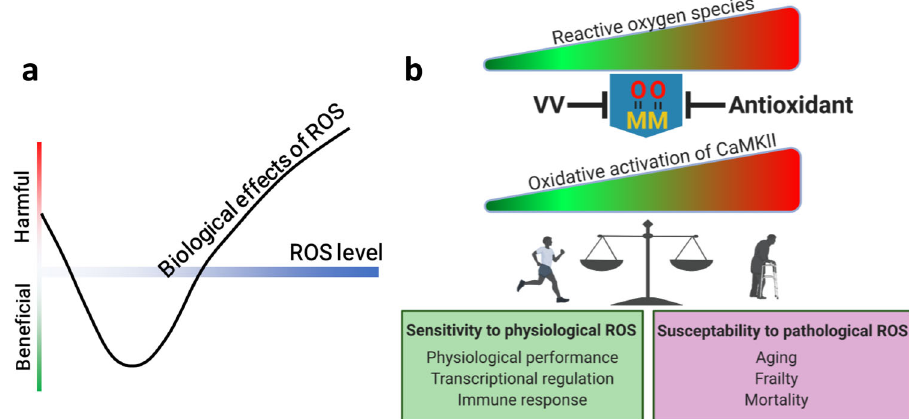
Fig. 7 The double-edged roles of CaMKII oxidation. a ROS induces a hormesis dose response, where too little or too much ROS are harmful, and optimal biological effects are achieved with an intermediate level of ROS. b ROS dictates the activity of CaMKII by oxidizing the MM/CM module. A physiological level of ROS allows CaMKII activity required for optimizing physiological functions, which is the likely reason for the evolution of the MM/CM module. Excessive oxidative stress induced by disease and aging hyperactivates CaMKII, which in turn aggravates frailty, diseases, and aging. Blocking oxidative activation of CaMKII by mutating MM residues to VV or by antioxidants protects against pathological processes accompanied by excessive oxidative stress, but also negates the physiological bene fi ts of CaMKII oxidation. Diagrams were created with BioRender.com. NATURE COMMUNICATIONS| (2021) 12:3175